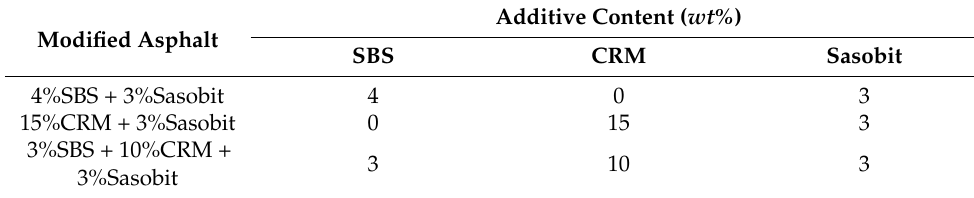
Table 5. Different asphalt modifier addition.